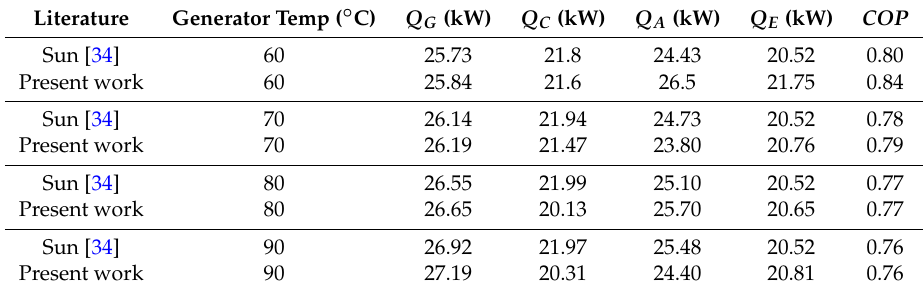
Table 7. Comparison of the energy flows and coefficient of performance ( COP ) at varied generator